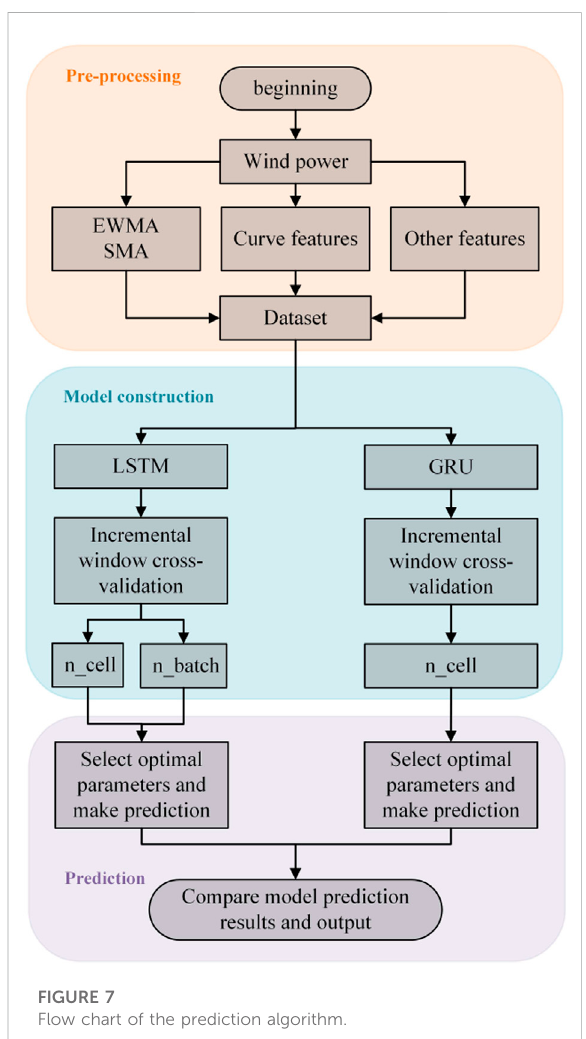
FIGURE 7 Flow chart of the prediction